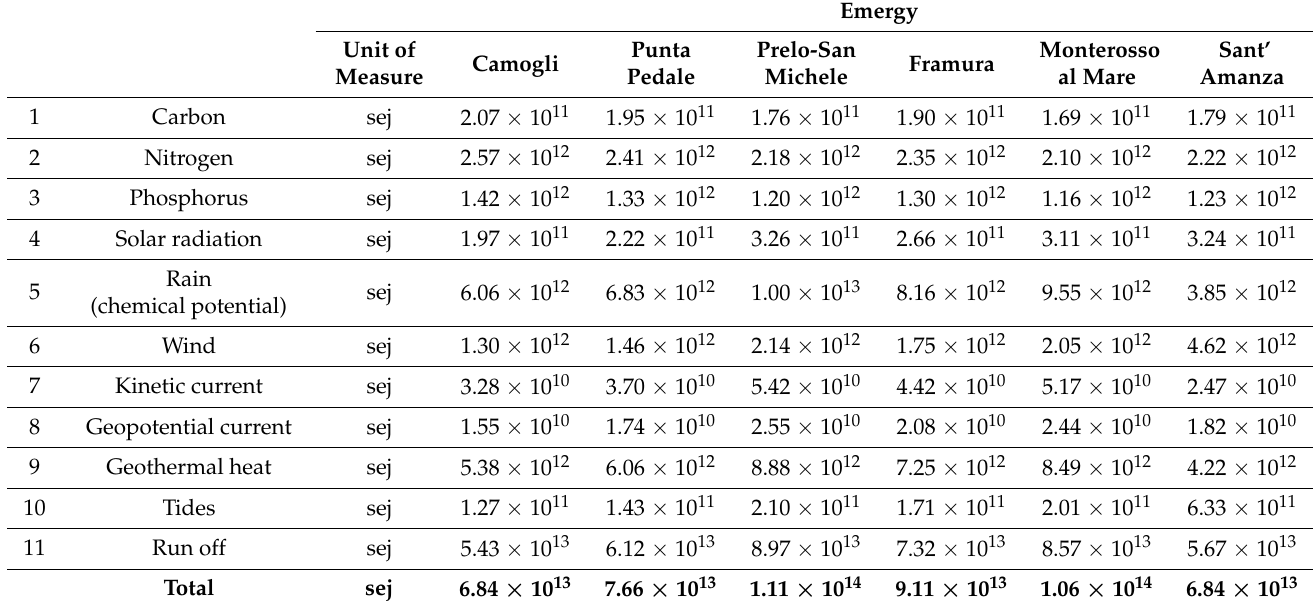
Table 5. Quantity of natural resources, expressed as emergy units, necessary to sustain primary production of the meadows